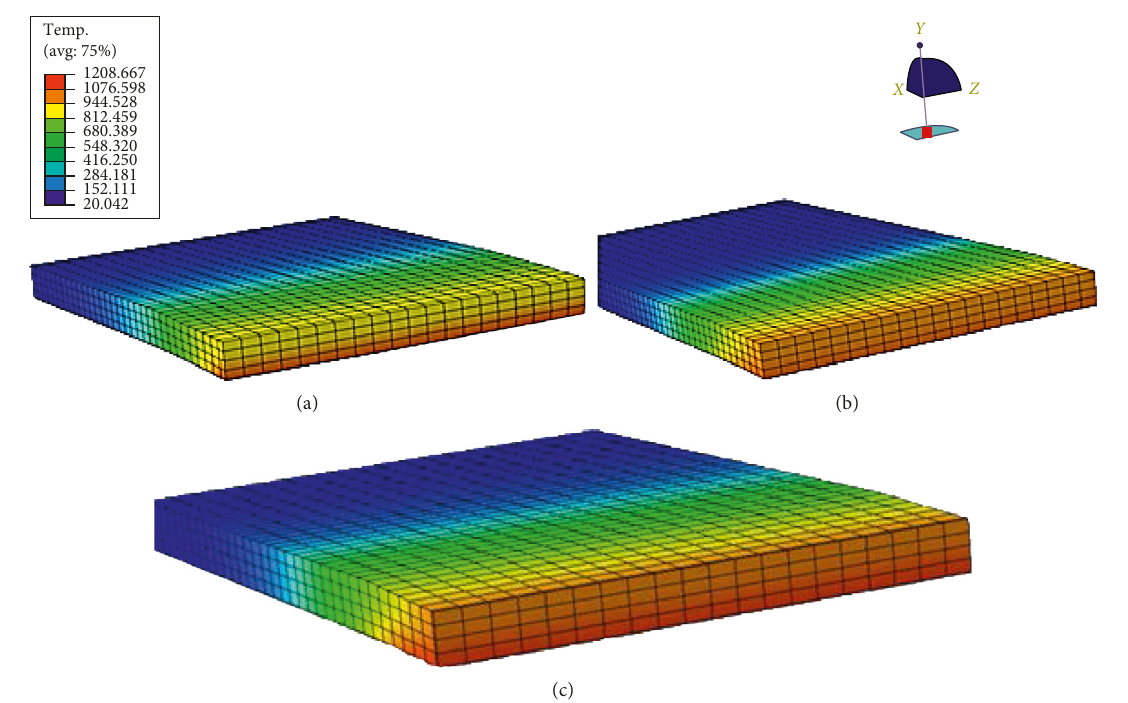
Figure 3: Distribution of temperature fields in the process of electrocontact surfacing during an electric current impulse t 0.02sec of the current pulse behavior (a); in 0.03sec of the current pulse behavior (b); at the exit from the thermal deformation hearth (c).